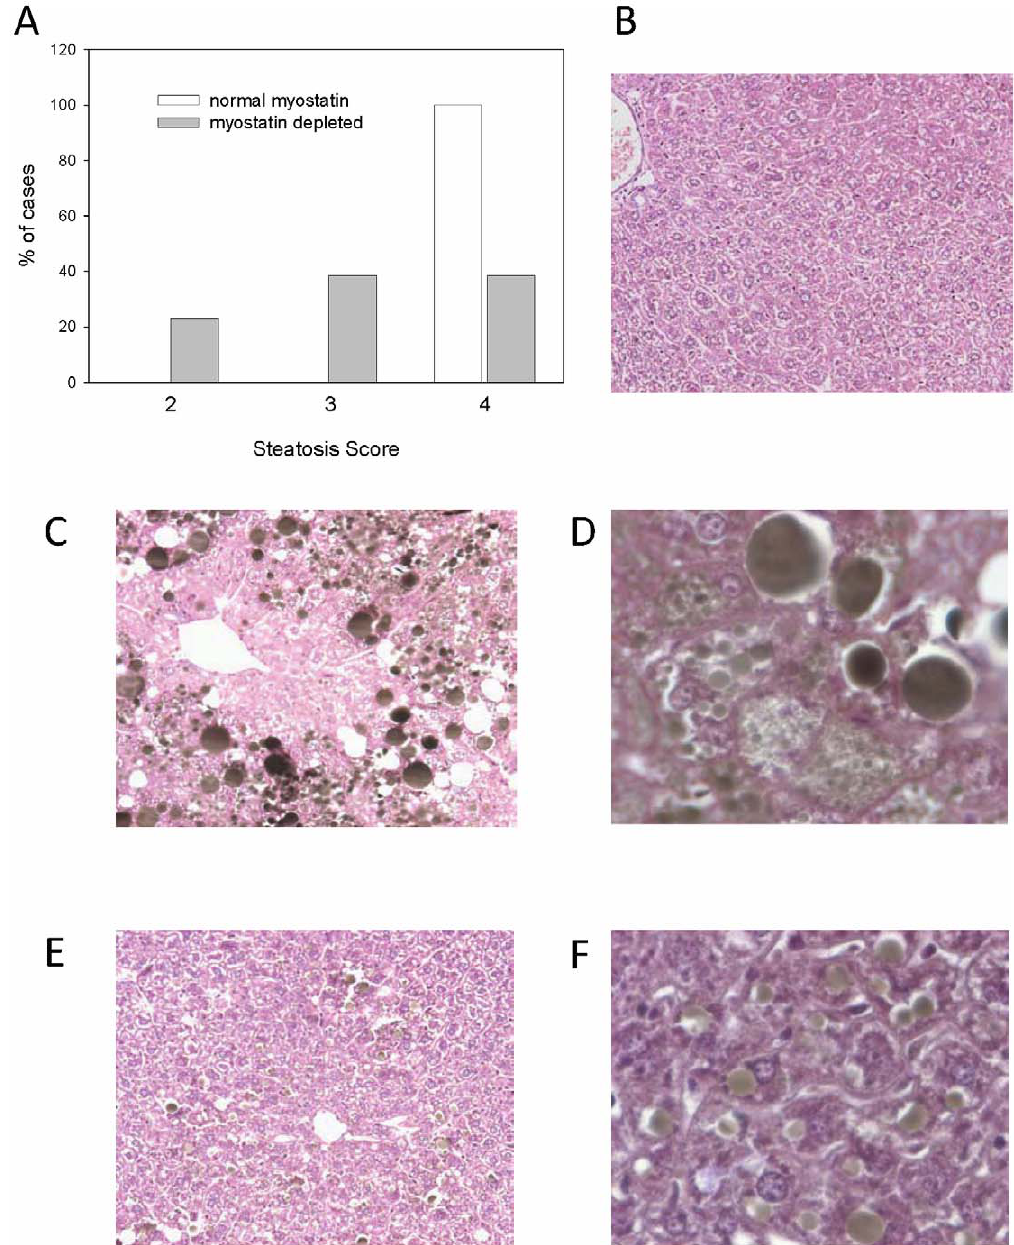
Figure 5. Hepatic steatosis scores and representative micrographs of liver sections. Distribution of steatosis scores (A) is based on examination of 12 mice with normal myostatin expression and 13 myostatin-deficient mice, all of which received the high-fat diet. Mice fed a low-fat diet did not have hepatic fat accumulation (B, Osmium H&E 6 250). Mice with normal myostatin expression had significant hepatic steatosis after 5 months of high-fat feeding (C 6 250; D 6 500). Larger lipid droplets often lift off the tissue leaving the clear spaces seen in the micrographs. Less fat accumulation was evident in livers of myostatin-deficient mice fed a high-fat diet for 5 months (E 6 250; F 6 500).